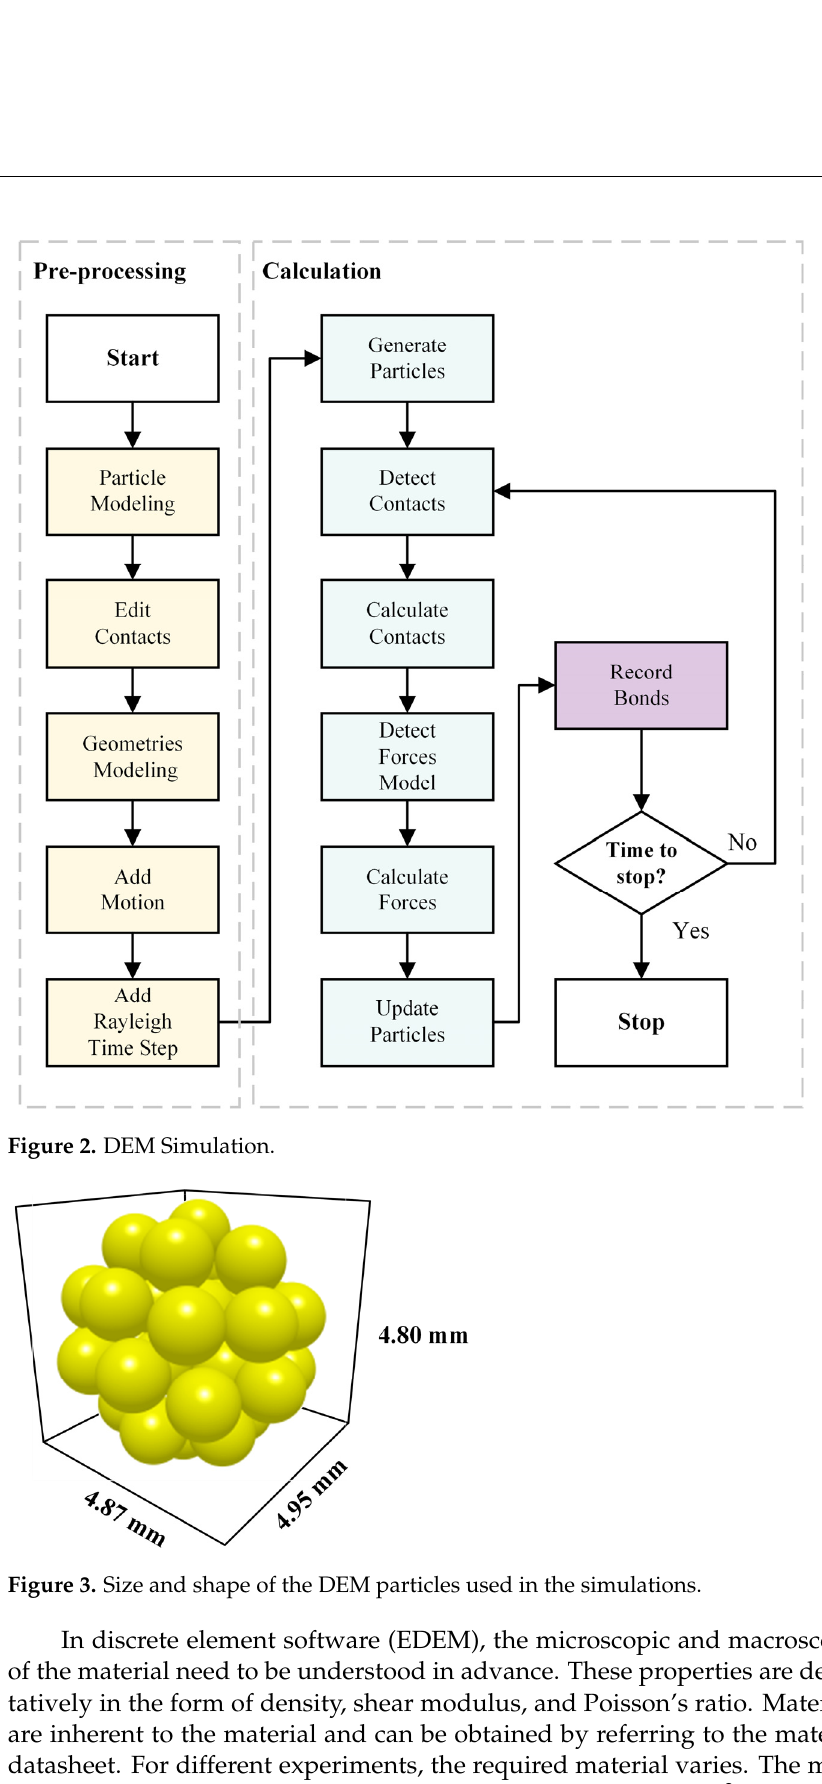
Figure 3. Size and shape of the DEM particles used in the simulations.